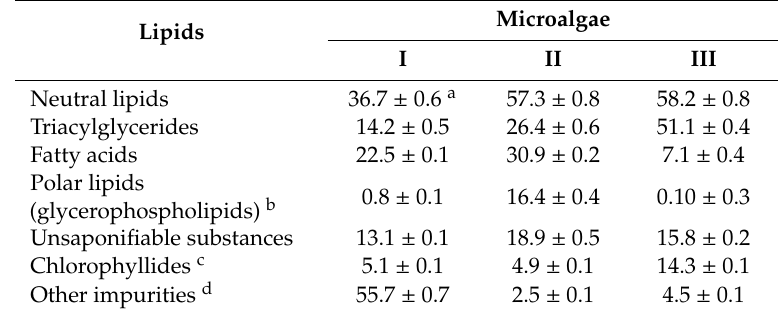
Table 4. The qualitative and quantitative content of the lipid fraction of the microalgae lipid complex.